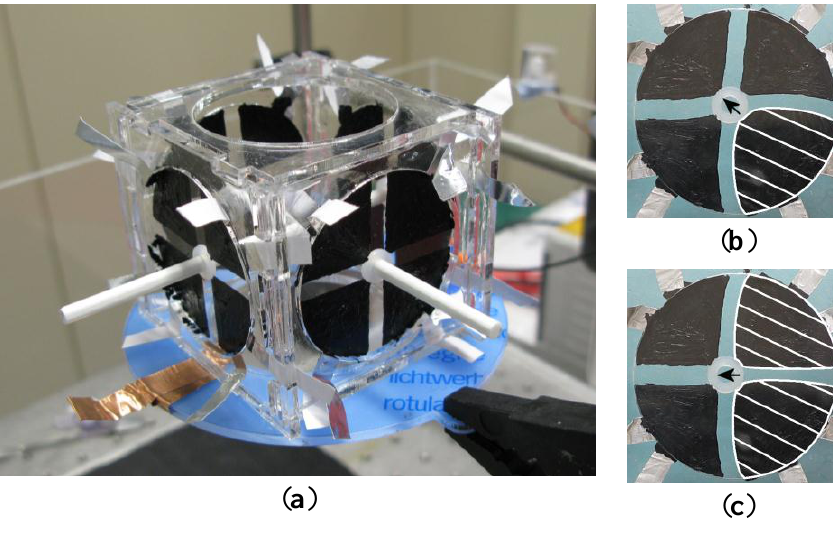
Figure 5. ( a ) Cube DEA prototype with 50 mm diameter membranes capable of 6-DOF actuation. Activated membranes shown with single active electrode ( b ); and with two active electrodes ( c ).